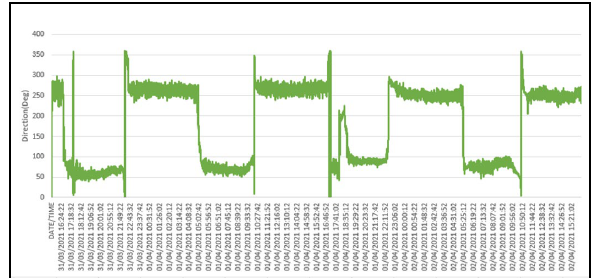
Figure 11. Graph above shows Speed Direction vs Time of the Full Day current data. The speed direction between 0 – 100 degree indicates the high tide phenomena while the direction between 200-300 degree indicates the low tide phenomena